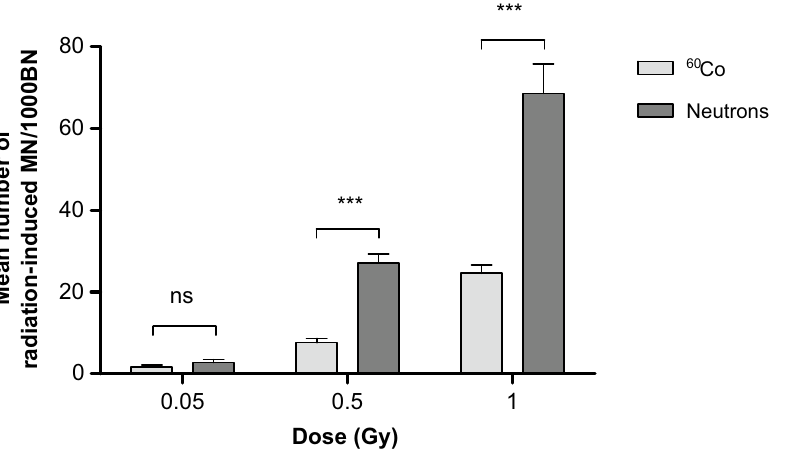
Figure 1. Mean number of micronuclei (MN) in CD34 + cells (n = 12) induced by different doses (0.05, 0.5 and 1 Gy) of 60 Co γ-rays and p(66)/Be(40) neuron irradiation. The number of MN induced by the irradiation was obtained by subtracting the mean number of MN in the non-irradiated controls (0 Gy) from the mean MN number scored in the irradiated samples. MN yields were significantly higher post-neutron irradiation compared to 60 Co γ-rays (*** p < 0.001) for the 0.5 Gy and 1 Gy dose (*** p < 0.001) but not for the 0.05 Gy dose (ns). Error bars represent the standard error of the mean (SEM) of the 12 different donors for each radiation quality. At least 1000 BN cells were scored for each donor per condition. No significant difference is indicated by